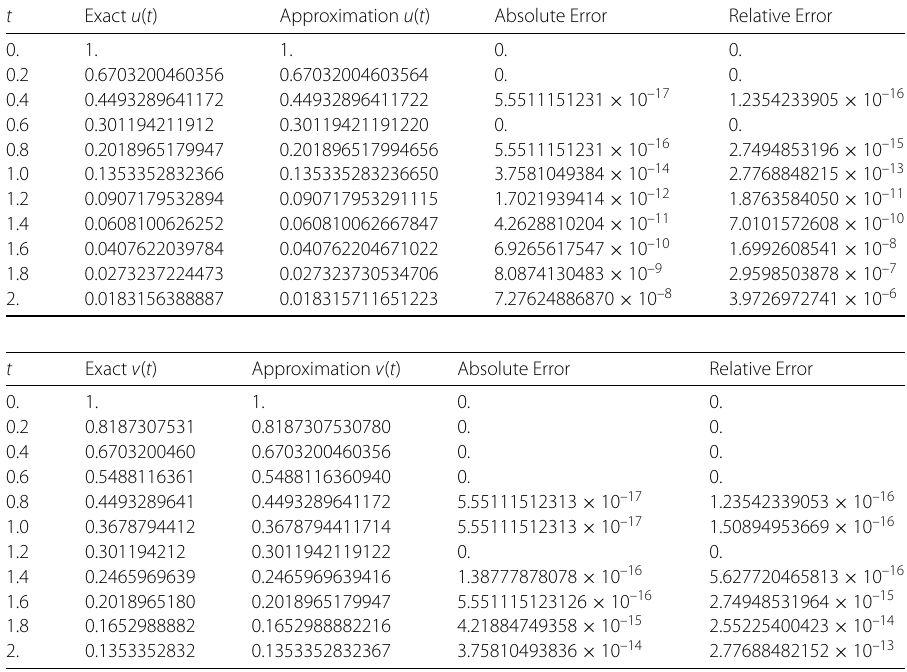
Table 3 Numerical results of FRPS method of Example 4.2